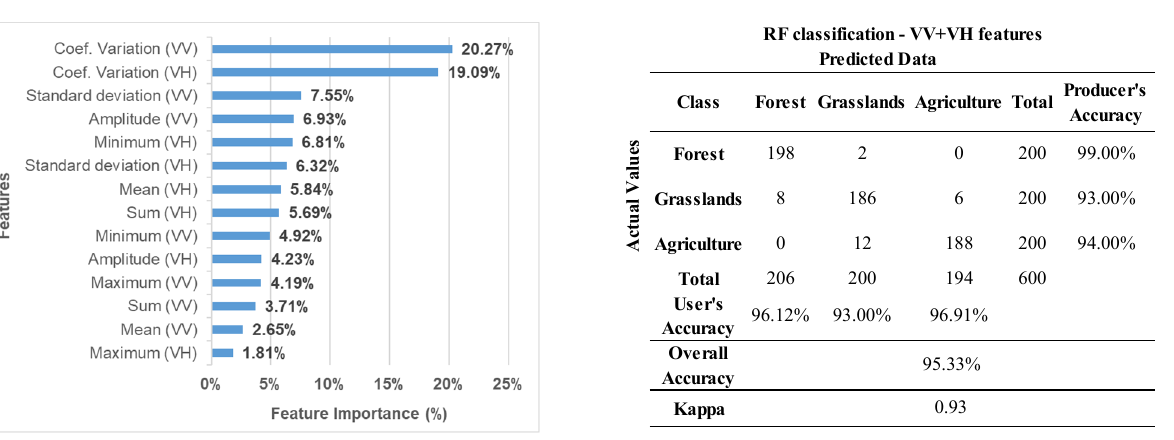
Figure 6. Importance of each temporal metric to the RF classification using the combined VV and VH features